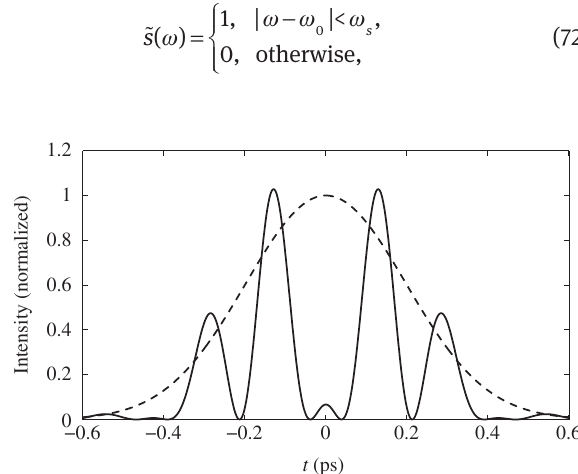
Figure 16: The intensity envelope of a superoscillatory pulse and a Gaussian (dashed line) with the same effective